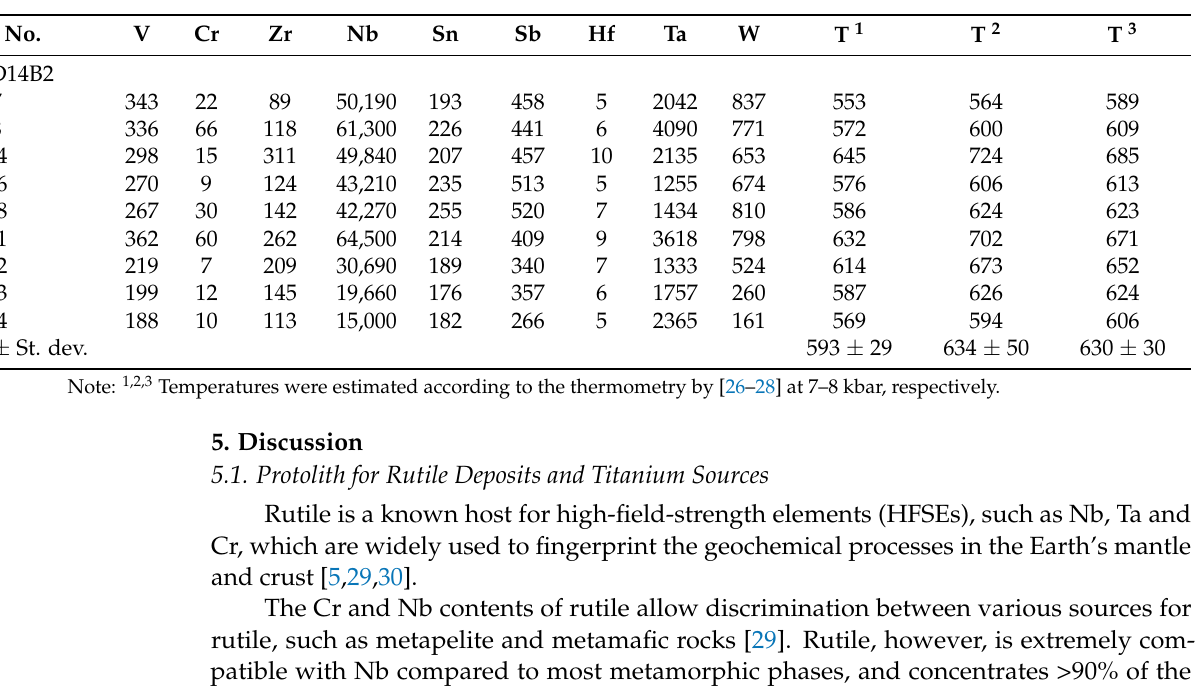
The LA–ICP–MS analyses of trace elements and estimated crystallisation temperatures of the rutile are listed in Table 4. The rutile from the Baishugang–Wujianfang district shows